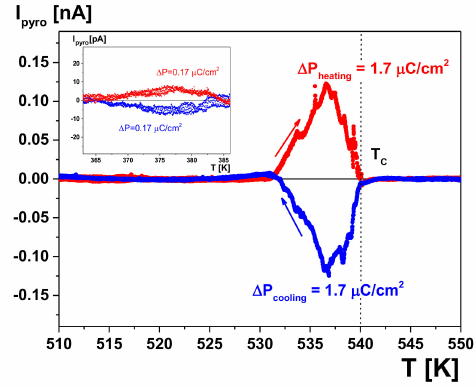
Figure 2. Temperature dependence of the pyroelectric current I pyro on heating (in red) and cooling (in blue) for virgin PbZ 0.87 Ti 0.13 O 3 crystal with the rate of 3 K / min, appearing against a background originating from thermally stimulated currents. Changes of polarization at Tc and at transition between ferroelectric phases (see inset) have been estimated as 0.17 and 1.7 µ C / cm 2 , respectively. The most important fact is that there is no thermal hysteresis for transition point at T C